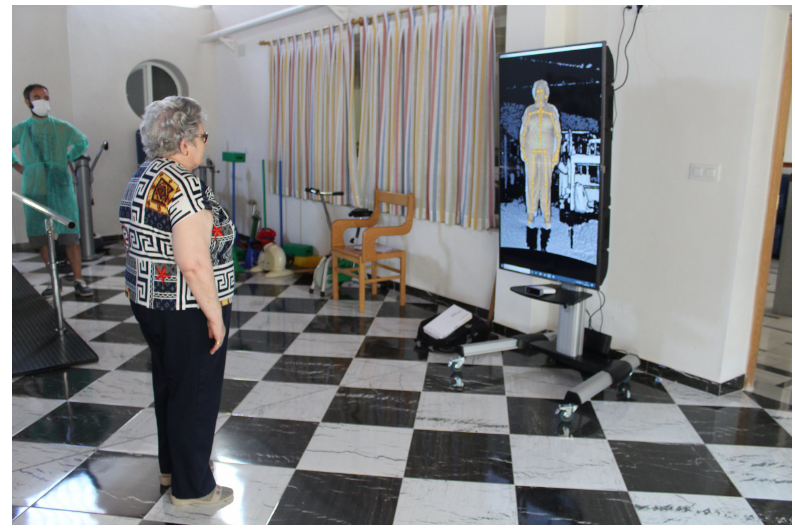
Figure 12. Phyx.io physical rehabilitation